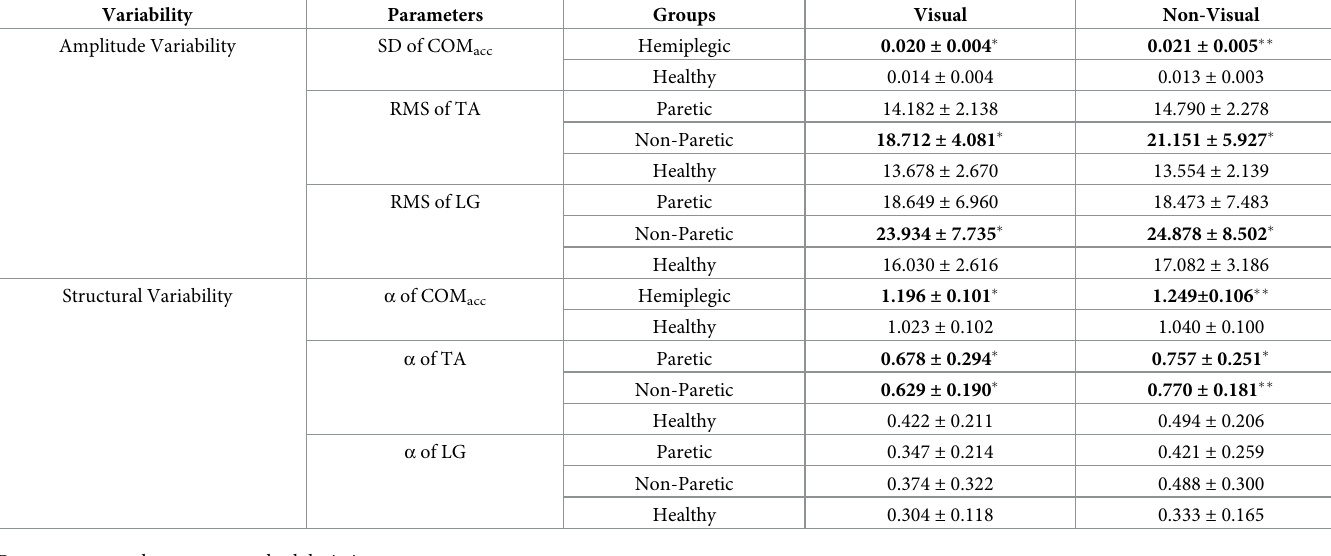
Table 2. Statistical analysis for amplitude and structural variability of patients and